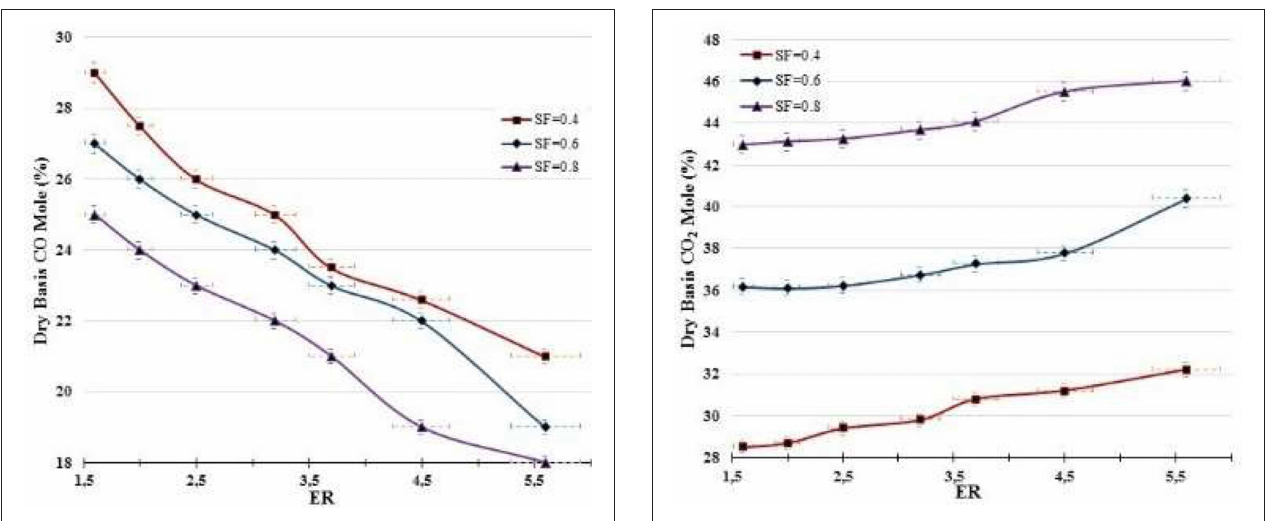
FIGURE 5 | CO concentration vs. ER at several SF values. FIGURE 6 | CO 2 concentration at several SF vs. ER.